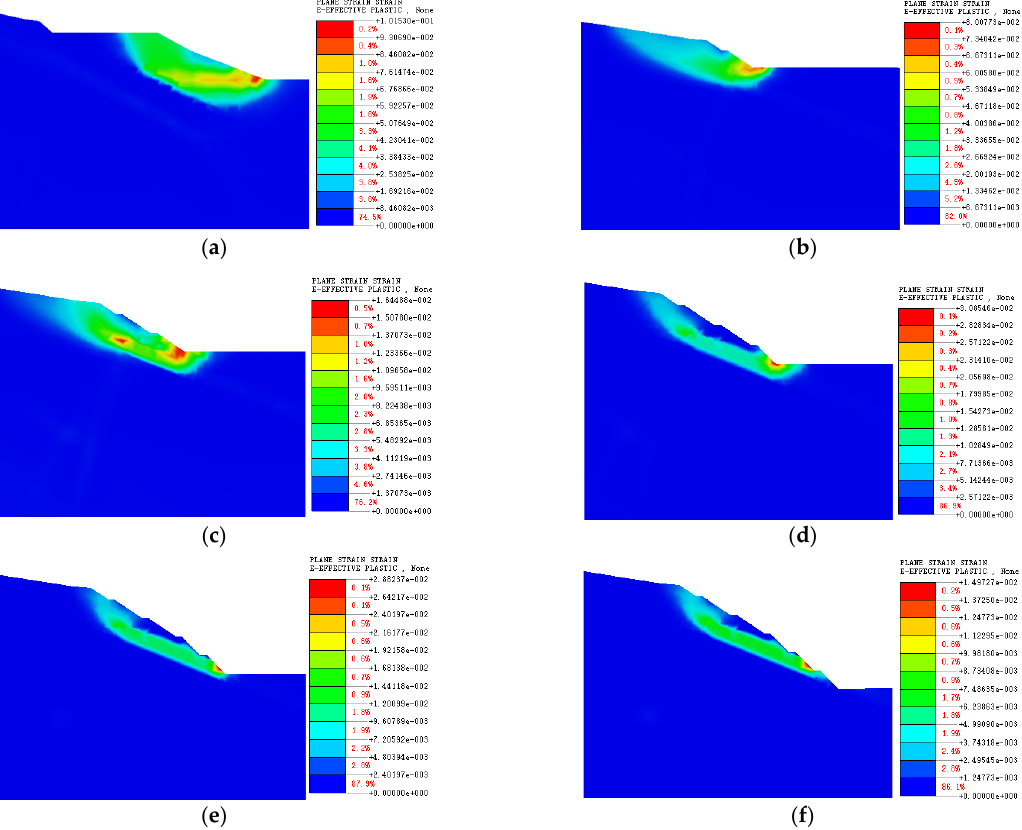
Figure 6. Changes in the plastic zone during excavation of Scheme No.2. ( a ) The first-class slope excavation; ( b ) the second-class slope excavation; ( c ) the third-class slope excavation; ( d ) the fourth-class slope excavation; ( e ) the fifth-class slope excavation; ( f ) the sixth-class slope excavation.